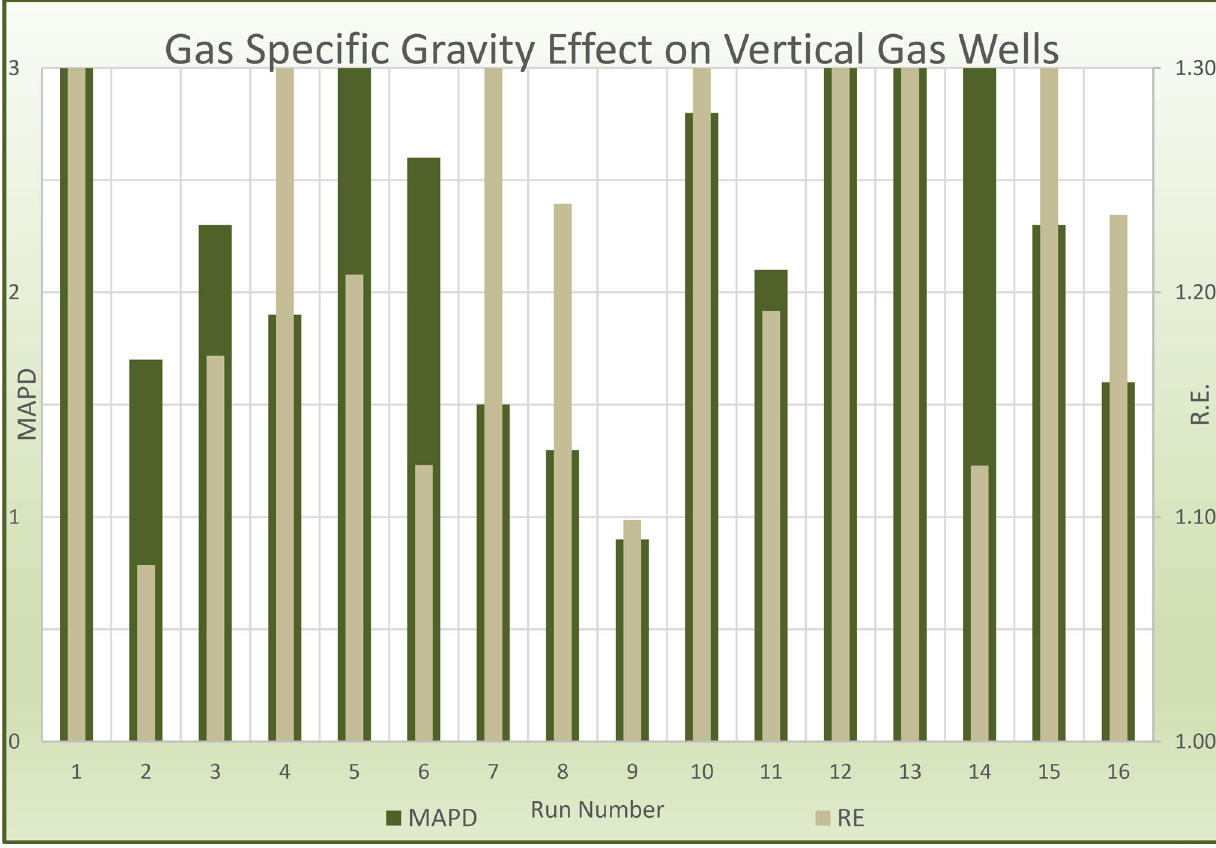
Fig. 7 Effect of gas specific gravity on vertical wells using MAPD and RE